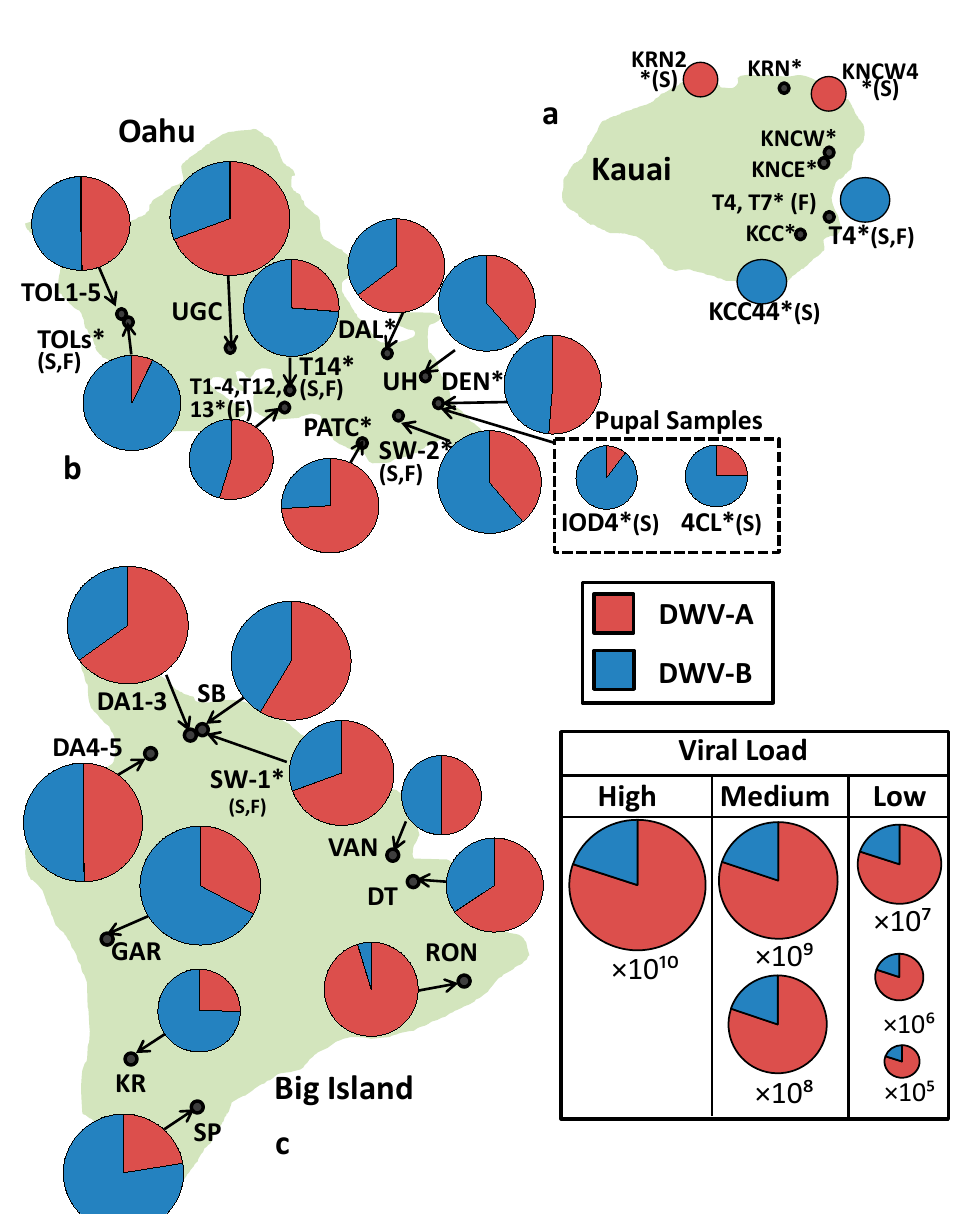
Figure 1. ( a – c ). Islands showing proportions of DWV-A RdRp (red) and DWV-B RdRp (blue) in each apiary (* = A colony that is not chemically treated for Varroa , S = Sample(s) came from a single colony, F = feral). The size of each pie chart is relative to the median total DWV genome equivalents per apiary.